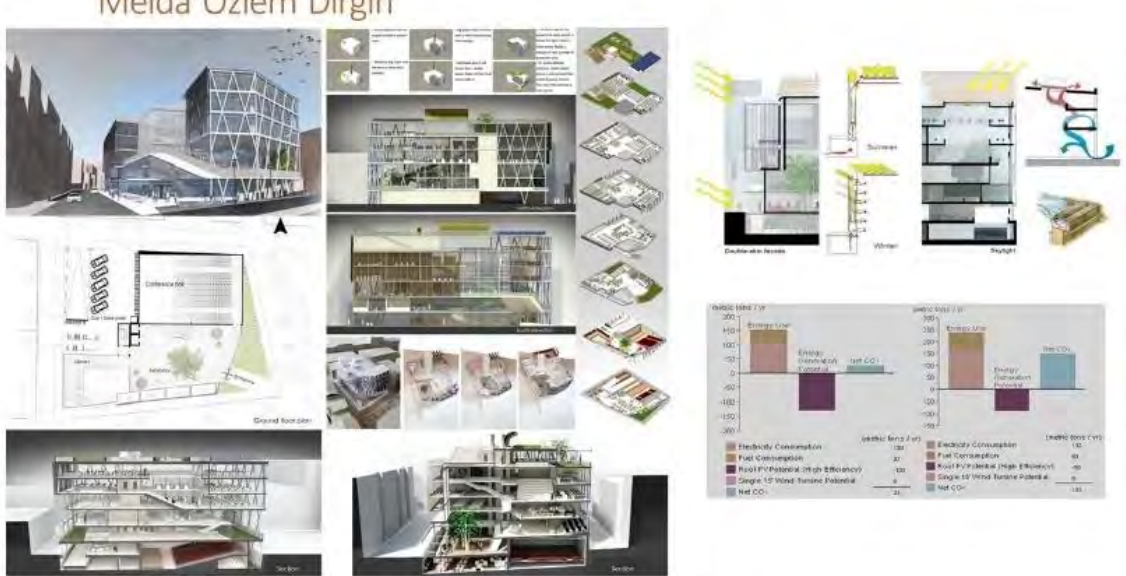
Figure 4. The designed Architecture department project incorporate the use of; natural light, natural ventilation with wind catchers, sustainable materials (constructed out of wood and steel), double skin fac¸ade, shading elements, green roofs, collecting rain water, reuse of grey water, and solar panels. The proposed design had %32 reduction in annual energy